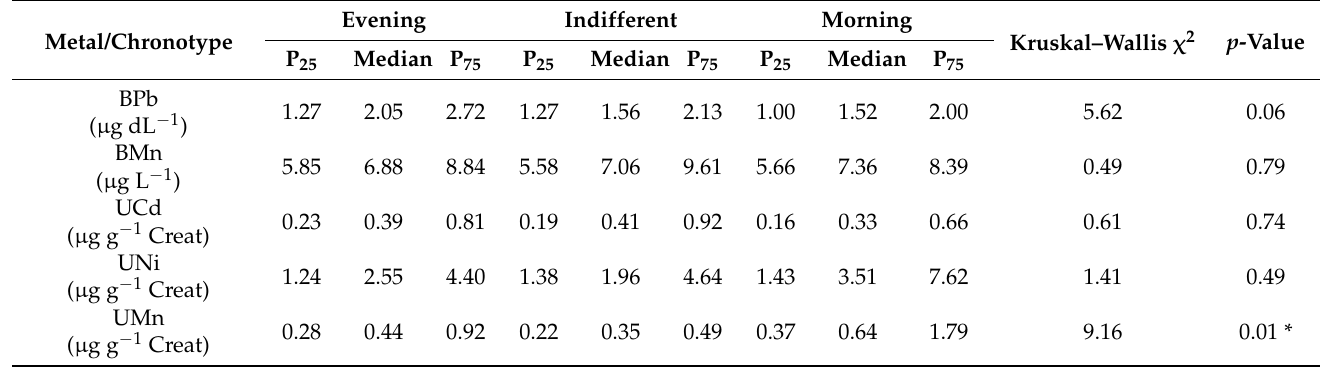
Table 3. Lead and manganese in blood, and cadmium, nickel, and manganese in urine according to PER3 gene VNTR polymorphisms.